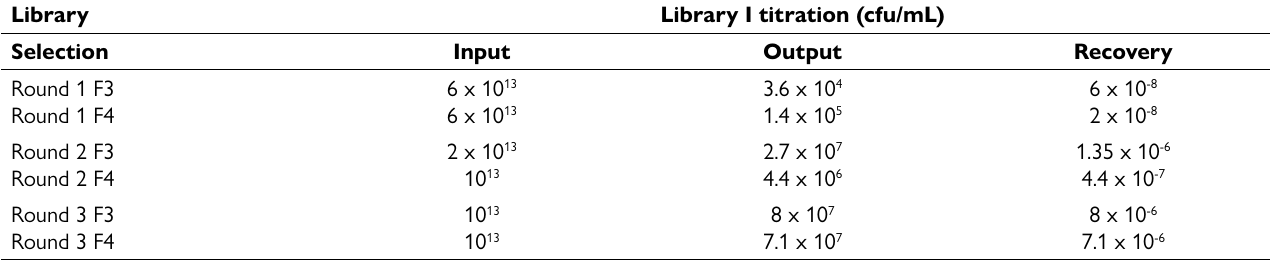
Table 1. Phage recovery through selection against fractions F3 and